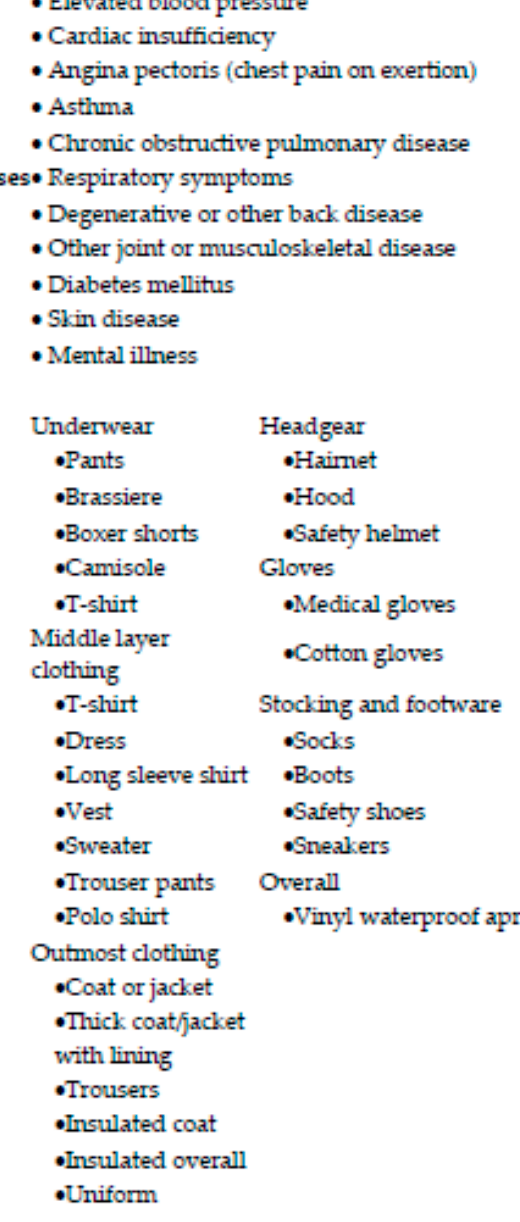
Figure A1. A selected part of the questionnaire used in this study.